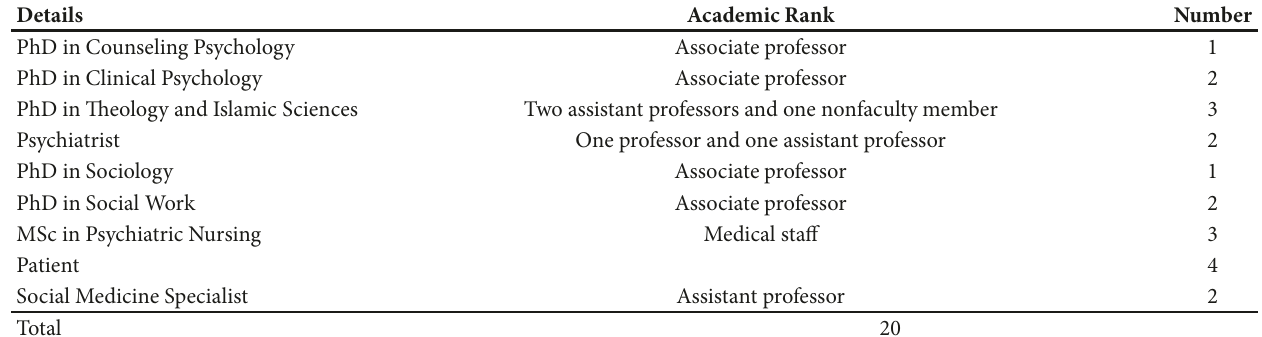
Table 1: Details of the 20 members of the panel of content validity